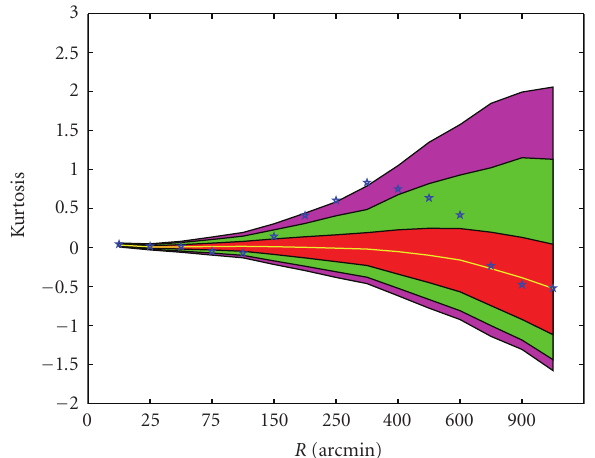
Figure 2: Figure showing the positive deviation of the kurtosis of the wavelet coe ffi cients at scales R of 250 and 300 arcmin found by [28]. Red, green and magenta regions represent the acceptance intervals at 32%, 5%, and 1%,